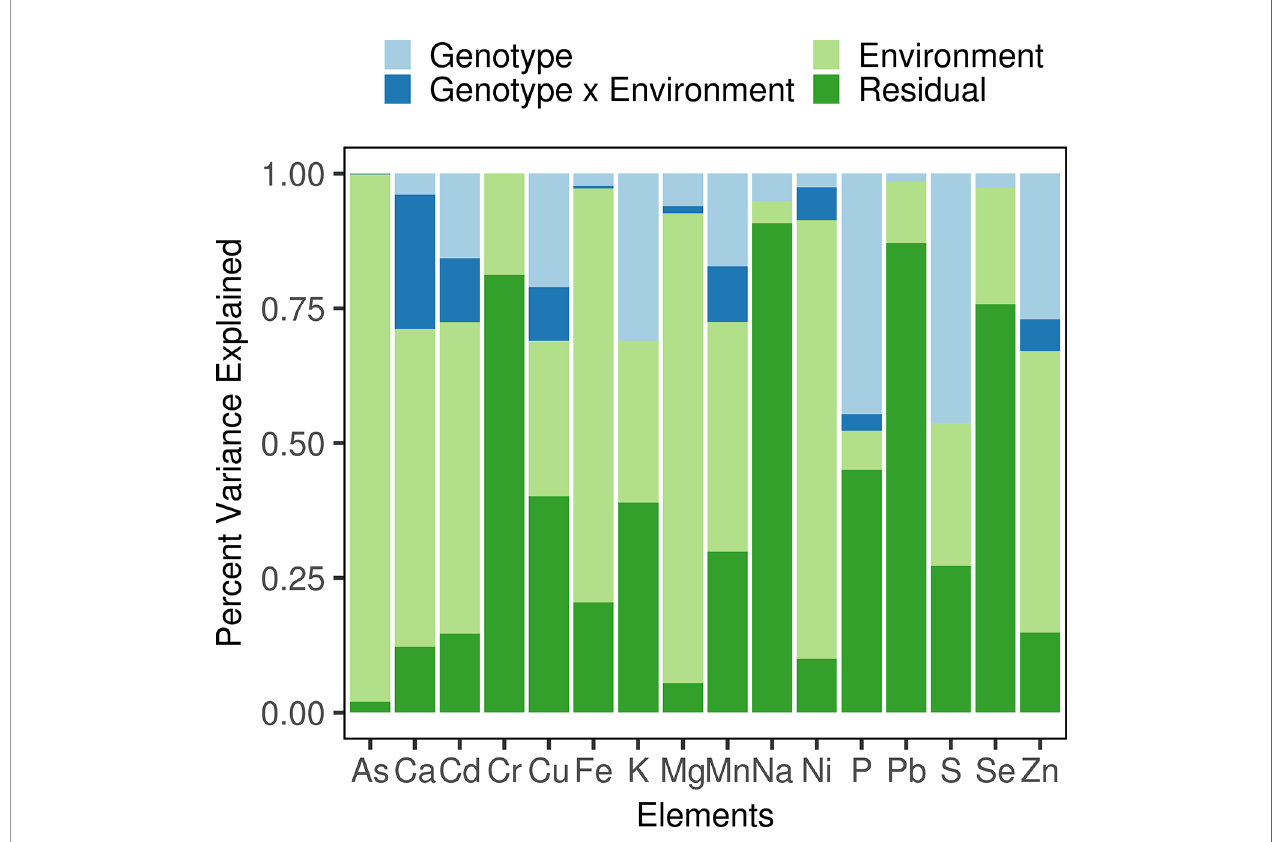
FIGURE 1 | Phenotypic variance component estimation. The proportions of the phenotypic variance attributed to each term were estimated using a linear mixed model and are shown in different